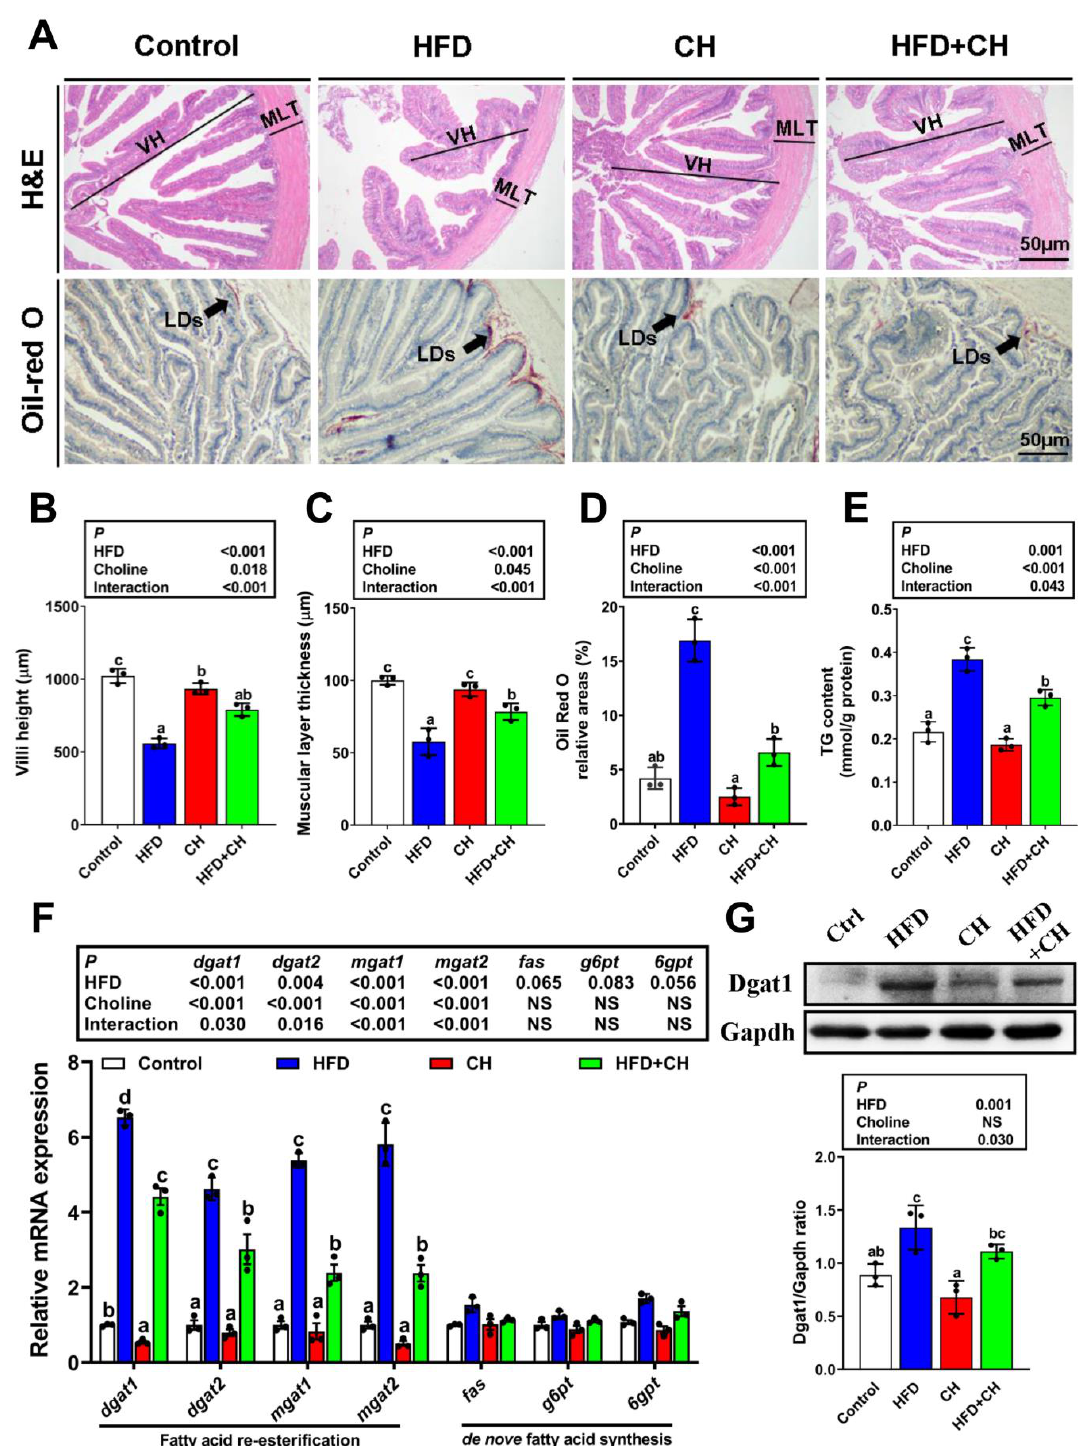
Figure 1. Dietary choline alleviated HFD-induced intestinal lipid dysregulation. ( A ) Representa- tive images of intestinal H&E and Oil red O stained. Scale bar, 50 μm; VM, villi height. MLT, muscular layer thickness. LDs, lipid droplets. ( B , C ) Relative intestinal villi height and muscular layer thickness in H&E staining. ( D ) Relative areas for LDs in Oil red O staining. ( E ) Intestinal TG content. ( F ) mRNA levels of the genes related to FA re-esterification and de novo FA synthesis. ( G ) Western blot analysis and quantification analysis for Dgat1. Data are mean ± SEM, n = 3. Labeled means without a common letter differ, p < 0.05 (2-factor ANOVA, Duncan’s post hoc test). NS, not significant ( p ≥